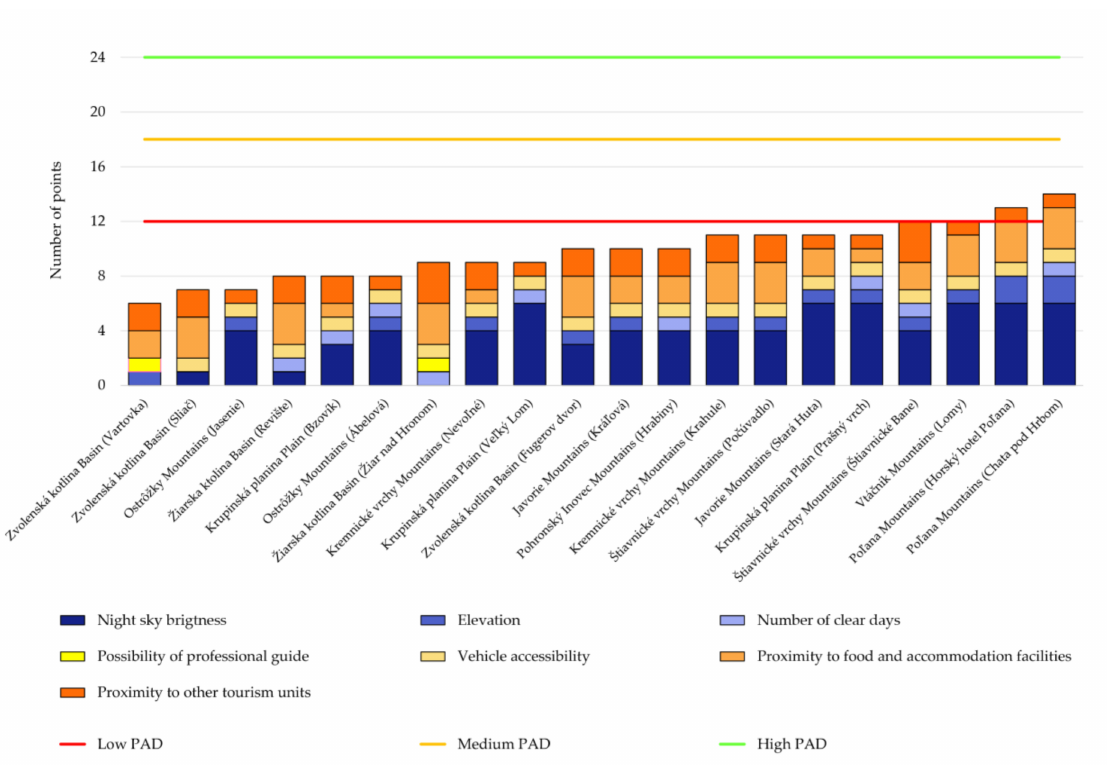
Figure 3. Potential for astrotourism development (PAD) at selected study sites and its categorization.